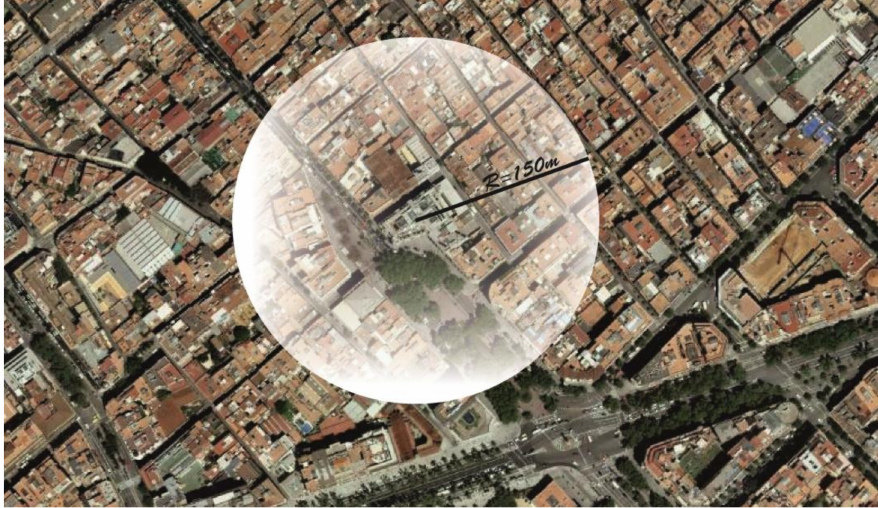
Figure 2. Aerial view of the area around Casa Fuster in Barcelona. Source: Own elaboration.